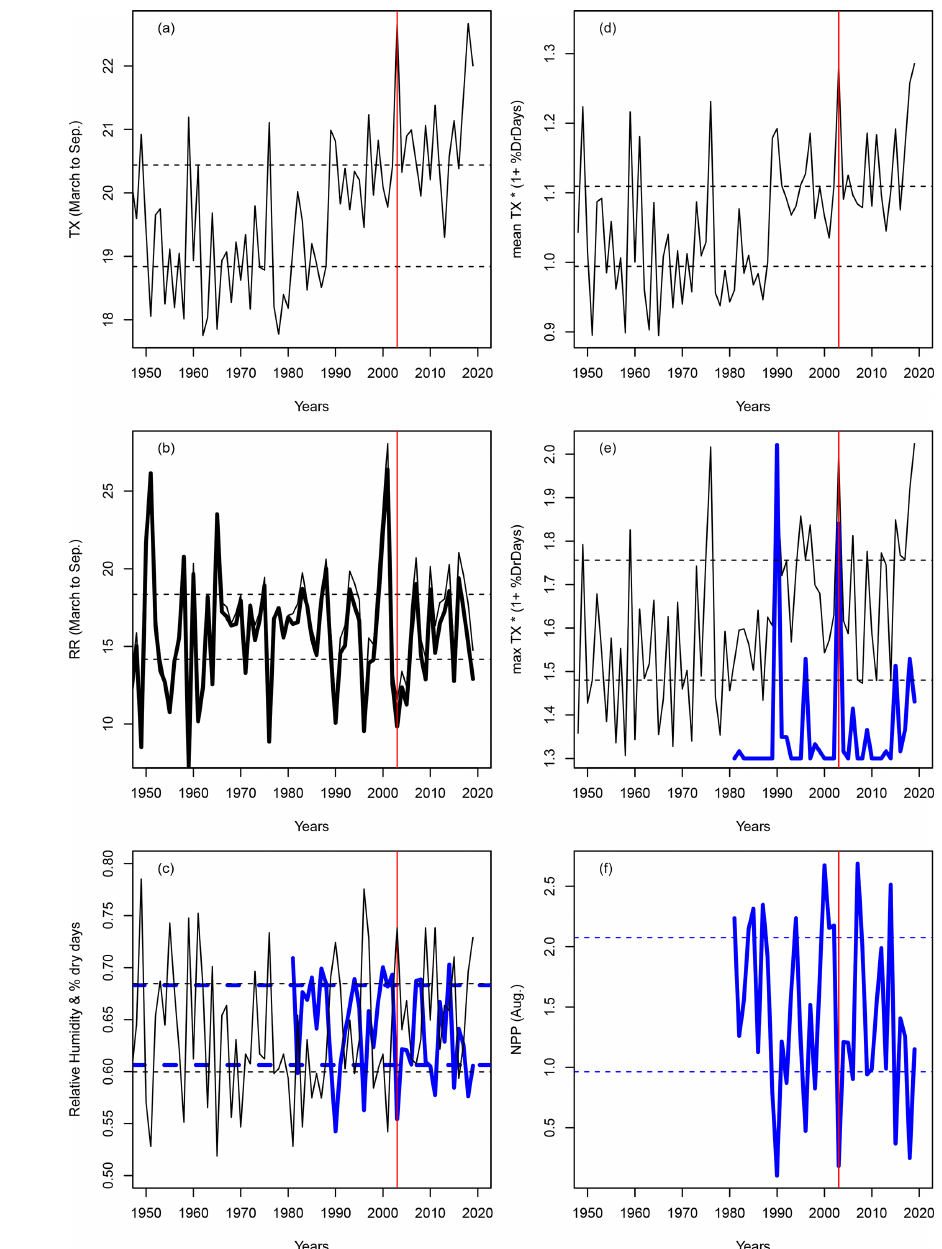
Figure A1. Variations in indices for Orly. Horizontal dashed lines show the q 25 and q 75 quantiles. The vertical red lines indicate the year 2003. (a) Average (March to September) temperature in Orly. (b) Average (March to September) precipitation in Orly (thin line) and the De Martonne index scaled by 28 (thick black line). (c) Percentage of dry days between March and September (black line) and relative humidity (thick blue line). (d) Mean value of I YV from March to September. (e) Daily maximum I YV (black line) and scaled number of days when NPP was below the 10th quantile (thick blue line). (f) NPP variations at Orly, as obtained from an ORCHIDEE model simulation forced by the ERA5